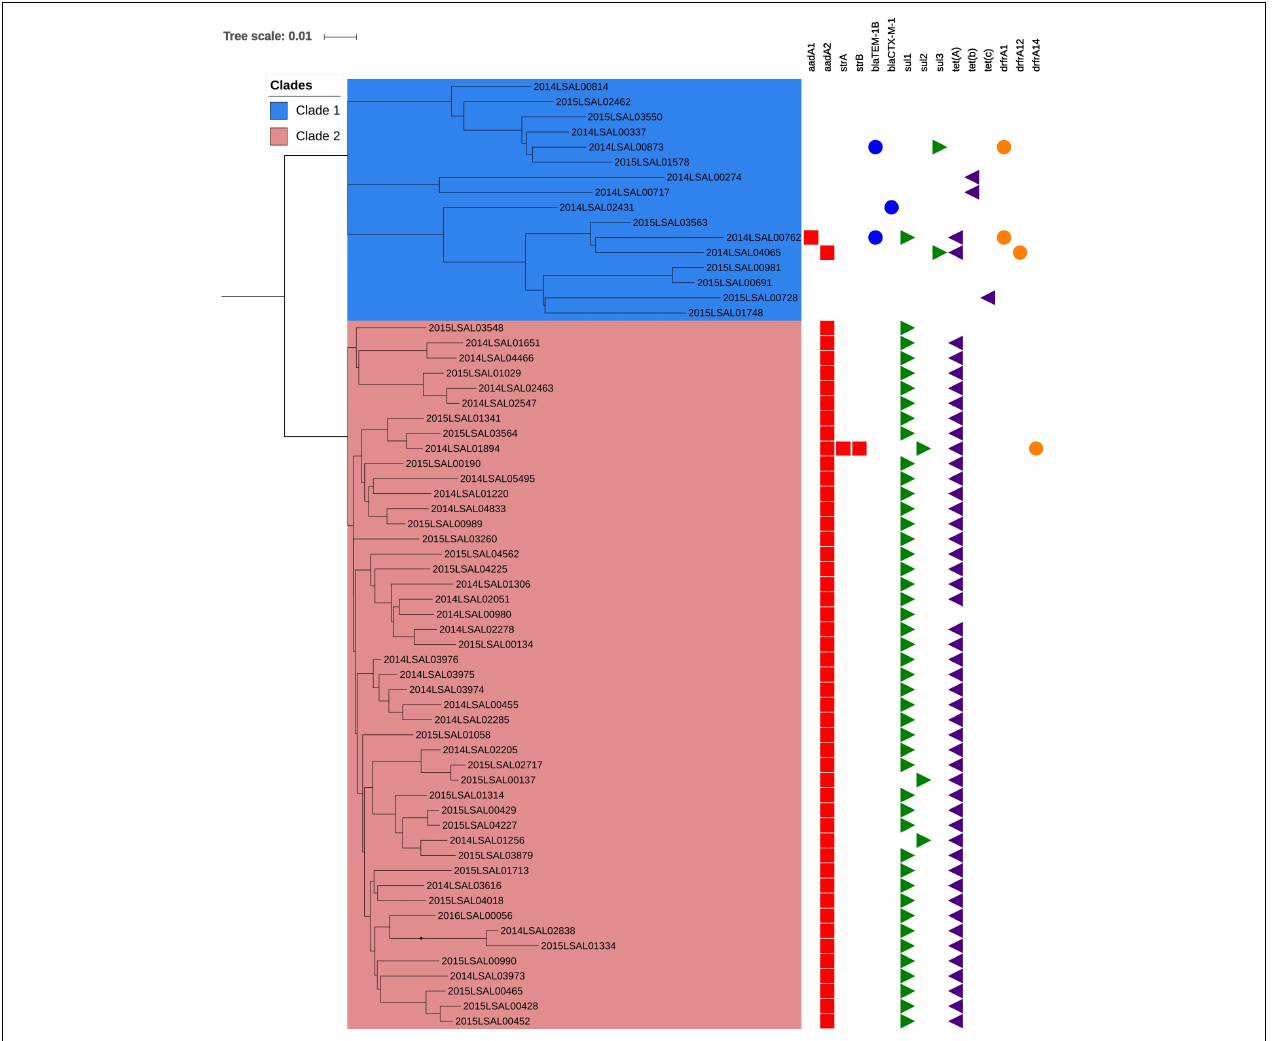
FIGURE 4 | Phylogenetic SNP tree of the strain from the cluster ST40. The scale bar indicates the number of substitutions per site. The box in blue corresponds to Clade 1 and the box in red to Clade 2. The predicted antibiotic resistance genes are indicated on the right. The red cubes correspond to the resistance gene to aminoglycosides antibiotic, the blue circle to beta-lactam, the green triangle to sulfonamides, the purple triangle to tetracycline, and the orange circle to